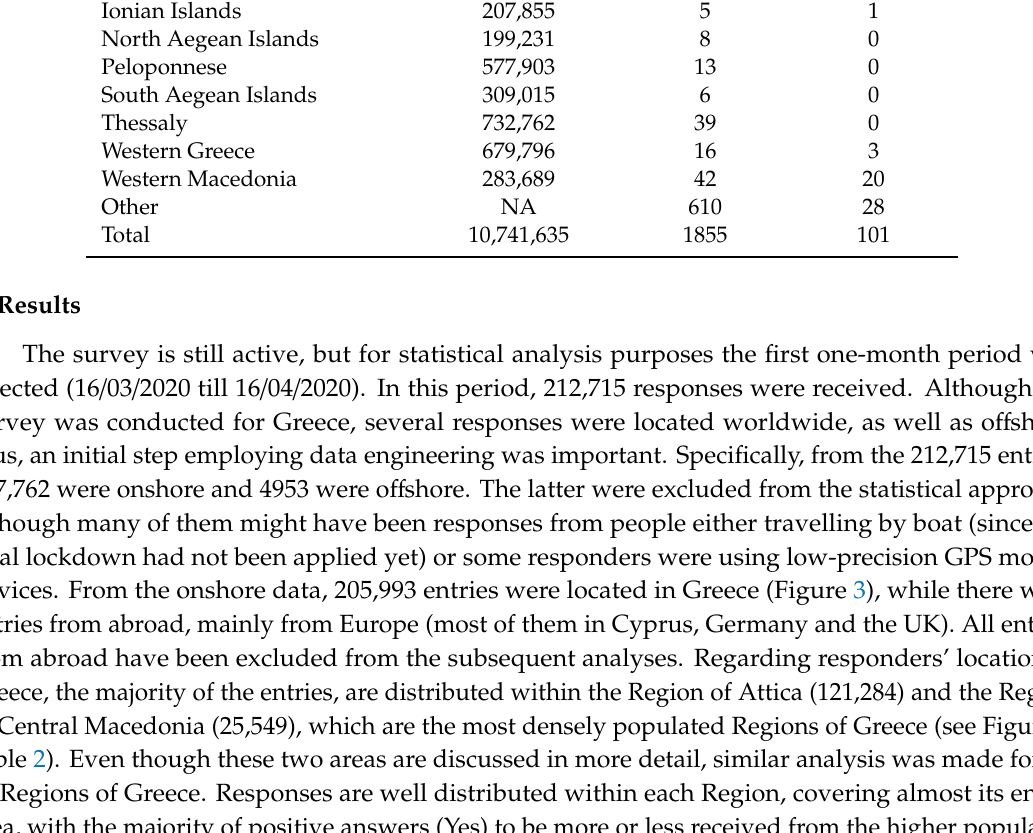
Table 1. Demographic data and o ffi cial COVID-19 records during the survey (Data Sources: * Hellenic Statistical Authority for 2019, ** https: // lab.imedd.org / covid19 / ). “Other” refers to unclassified cases, or cases located in cruise ships, or refugee camps (COVID-19 data last updated on 16 / 04 / 2020). Regions Population * Cases ** Deaths ** Attica 3,753,783 993 31 Central Greece 547,390 7 0 Central Macedonia 1,882,108 72 8 Crete 623,065 10 1 Eastern Macedonia and Thrace 608,182 27 Epirus 336,856 0 Ionian Islands 207,855 North Aegean Islands 199,231 Peloponnese 577,903 South Aegean Islands 309,015 0 Thessaly 732,762 Western Greece Western